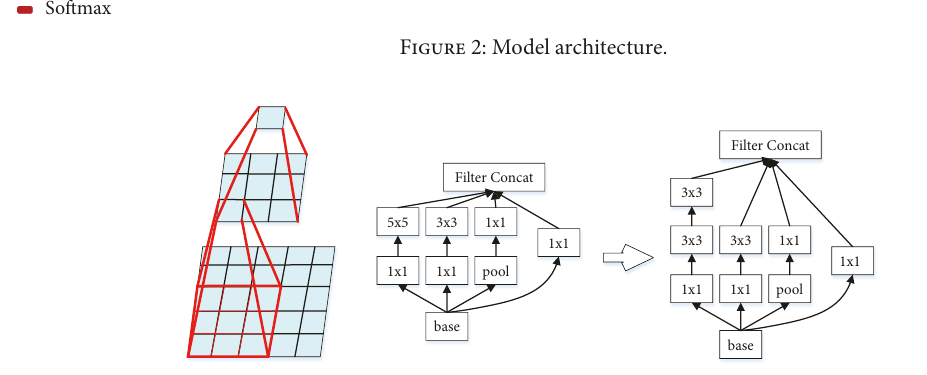
Figure 3: Mini-network replacing the 5 × 5 convolutions.